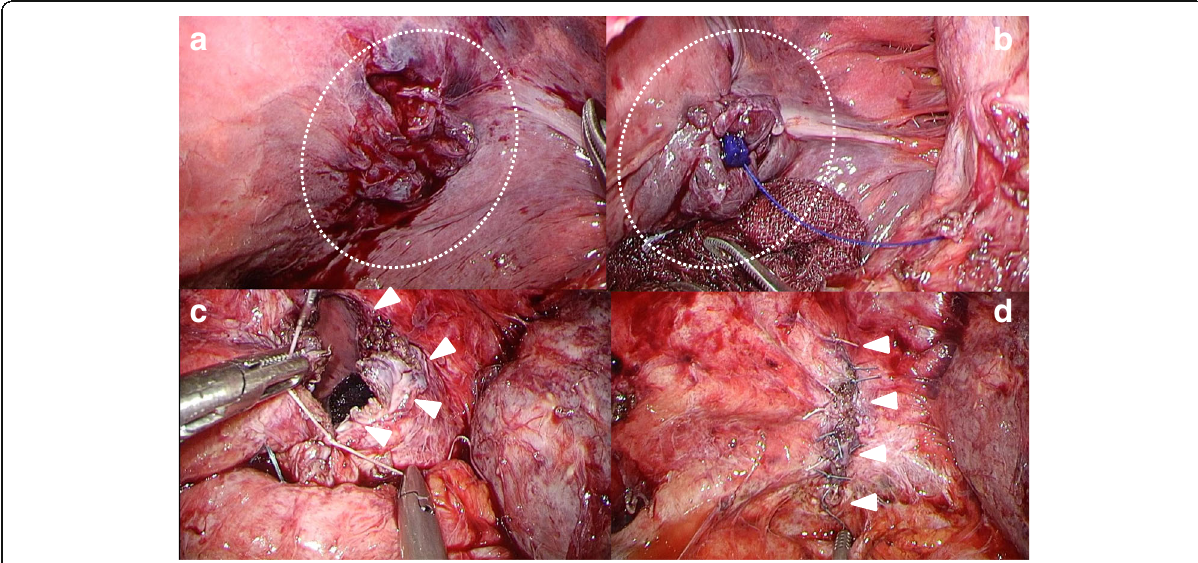
Fig. 3 Operative findings. a The damaged pleura of the lung was peeled away from the transverse colon (circle). b Damaged pleural lining was repaired laparoscopically, using a trans-diaphragmatically (circle). c We closed the defect laparoscopically, using a non-absorbable 2 – 0 polyester suture (arrow heads). d Image of the repaired diaphragm (arrow